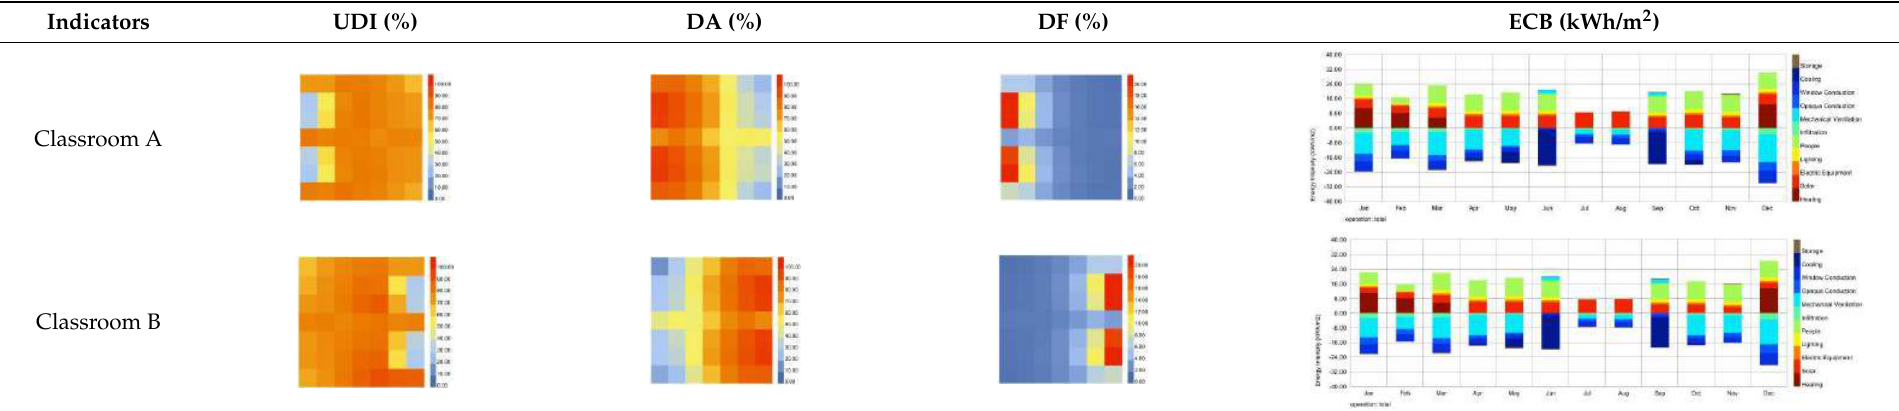
Table 3. Image results for six classrooms.